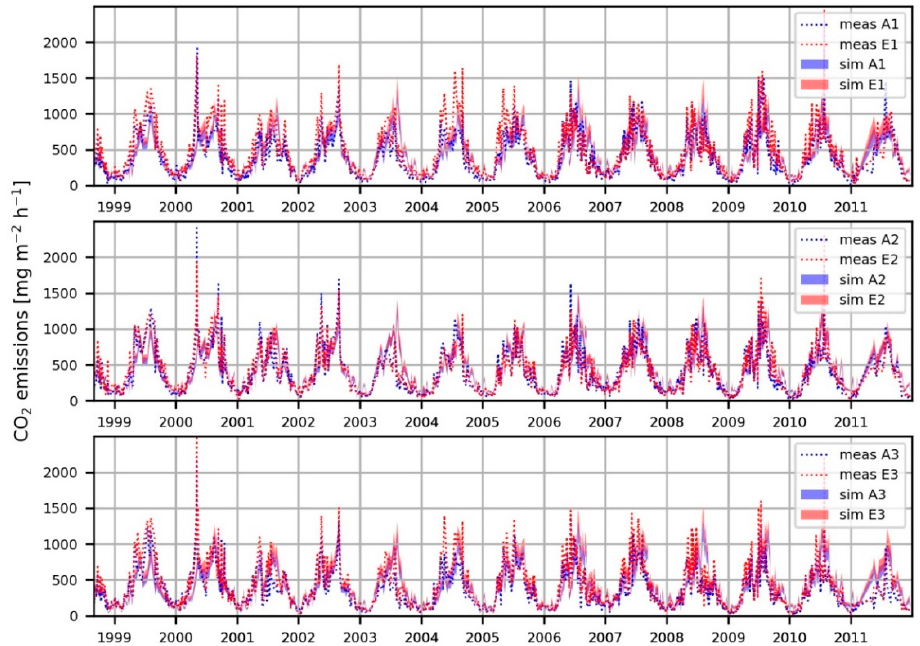
Figure A2. Time series of CO 2 emissions. Measurements are depicted in lines, and confidence intervals of simulations are depicted as colored areas.